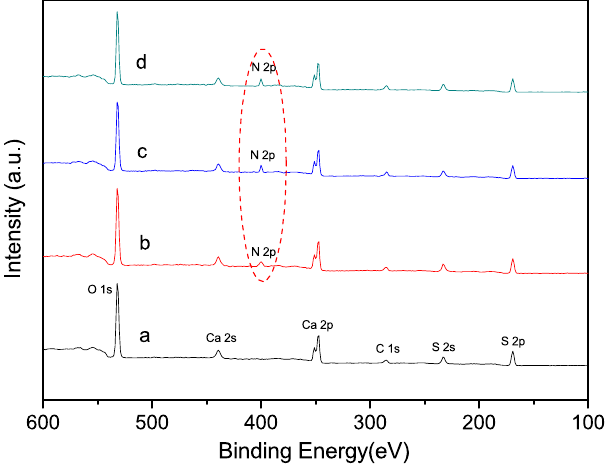
Figure 7. XPS wide scan of α -HH whiskers prepared with different concentration of CTAB in glycerol (65 wt%)-water solutions with 5% KCl (by weight of FGD gypsum) at 90 °C for 45 min (( a ) 0; ( b ) 0.05%; ( c ) 0.15%; ( d ) 0.25%).